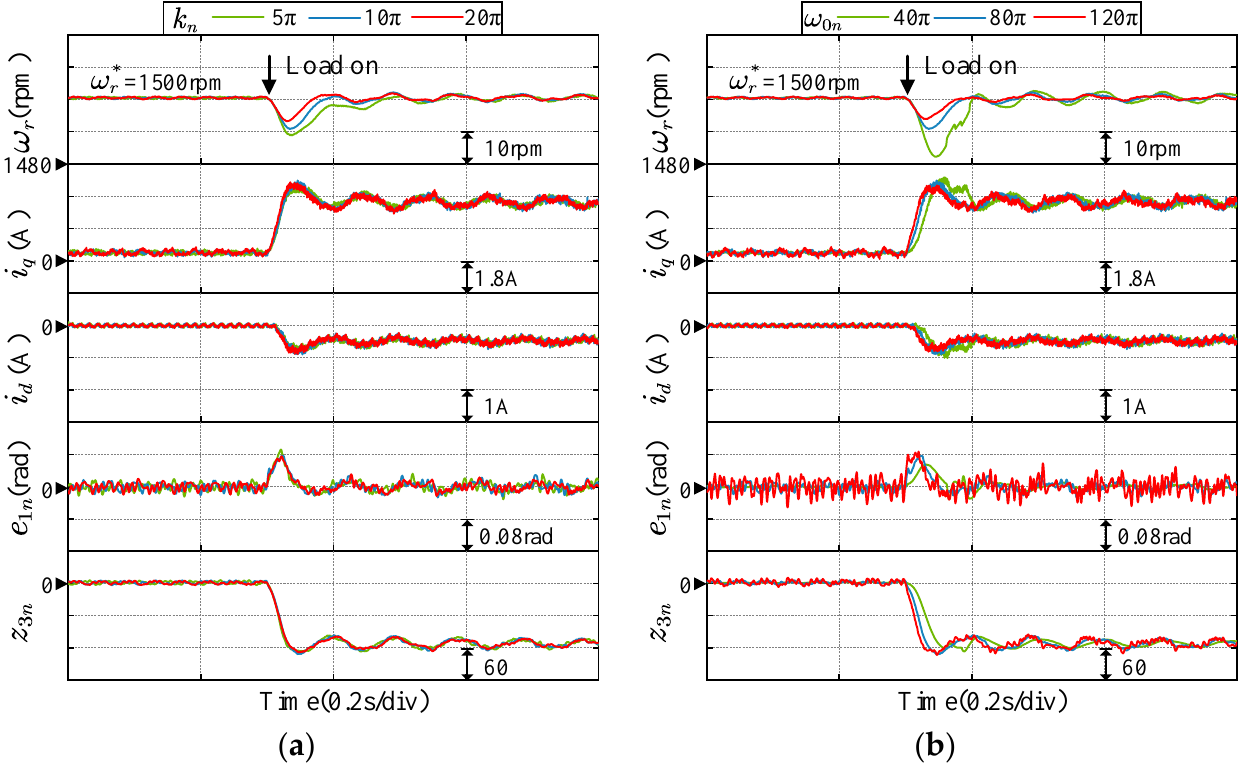
Figure 15. Experimental results of the speed response with step load disturbance. ( a ) Under